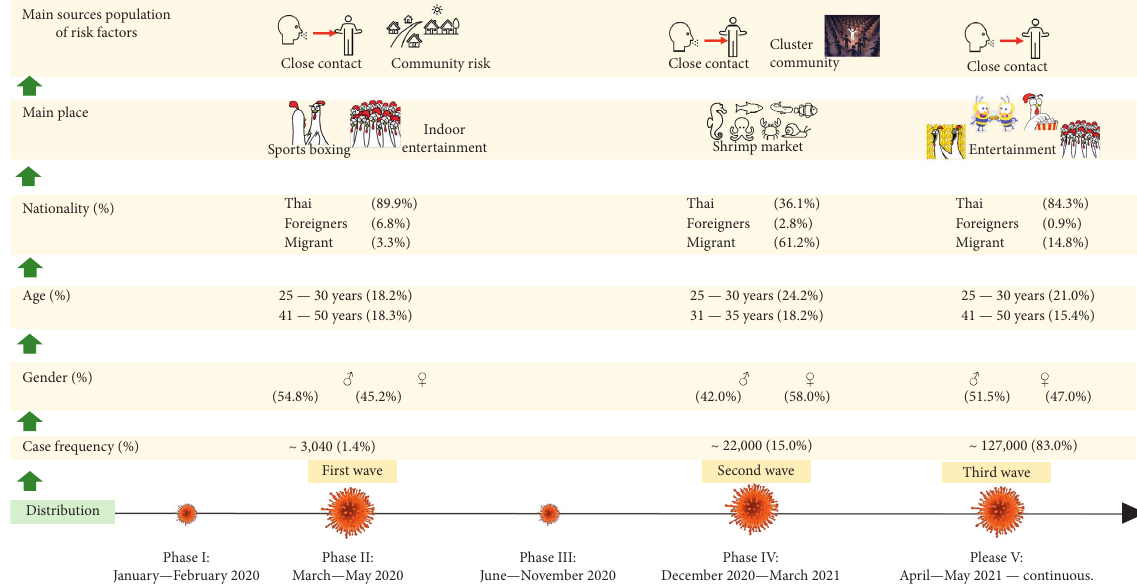
Figure 2: Summary for different waves during the COVID-19 pandemic in